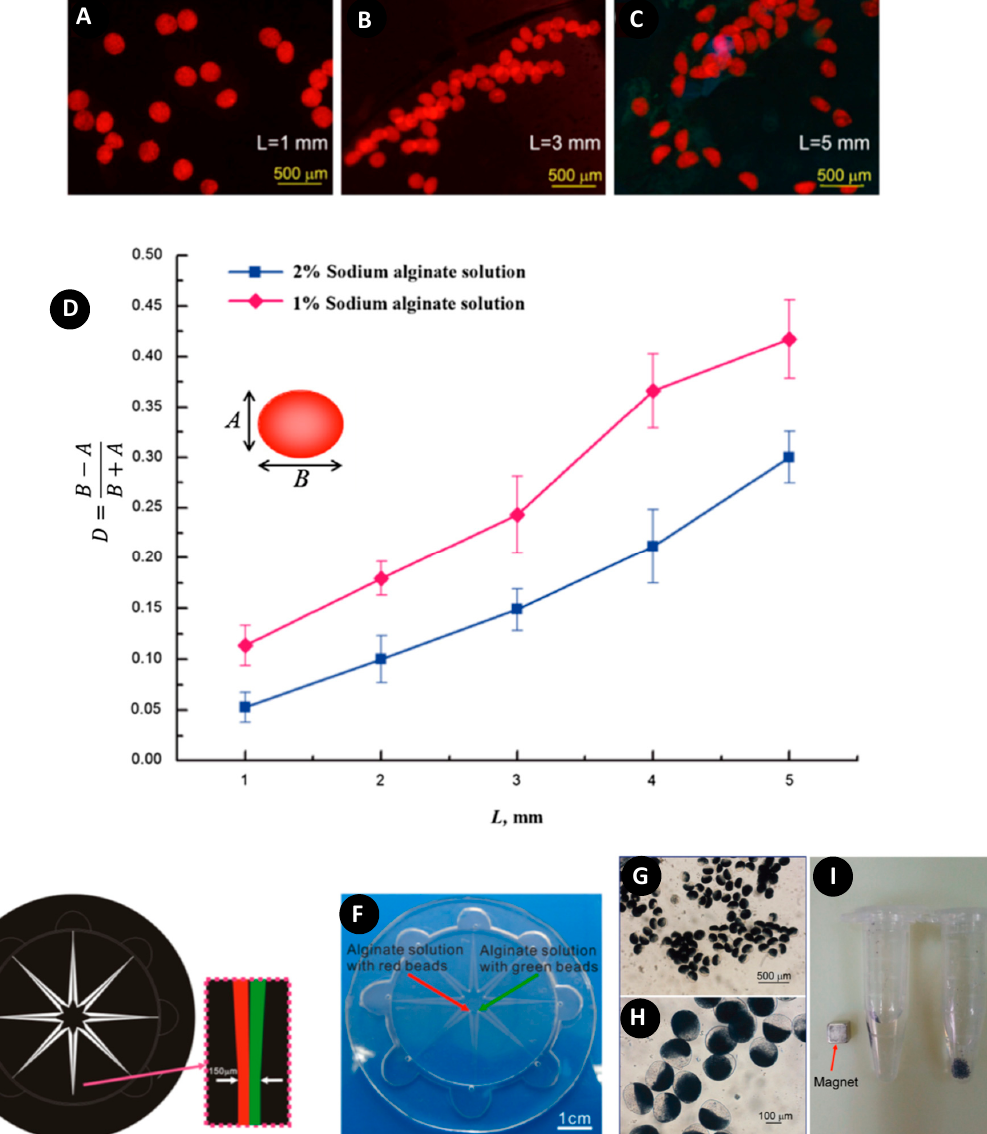
Figure 10. ( A – C ) Fluorescence images of produced polymeric particles by adjusting the airgap (L); ( D ) Effect of the airgap distance (L) on the deformation of the particles (D) in different Na-alginate concentrations; ( E , F ) Production of Janus particles on centrifugal microfluidics; ( G , H ) Production of magnetic Janus particles; ( I ) Manipulation of magnetic Janus particles with a magnet. Reprinted with permission from [79].